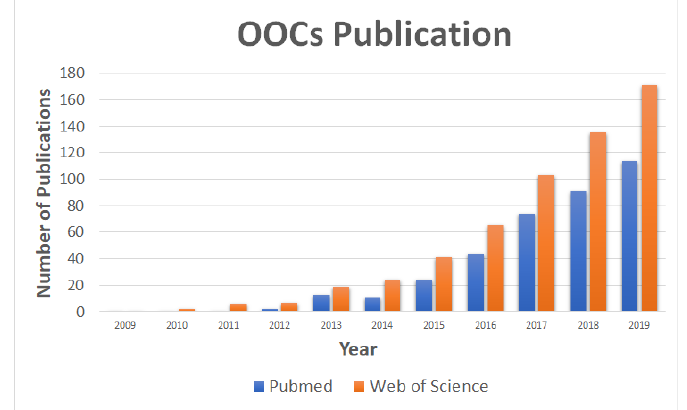
Figure 1. The publication history of organs-on-chips (OOCs) over the past decade according to Web of Science and Pubmed. “Organ-on-a-chip” and “Organs-on-Chips” were the keywords utilized.